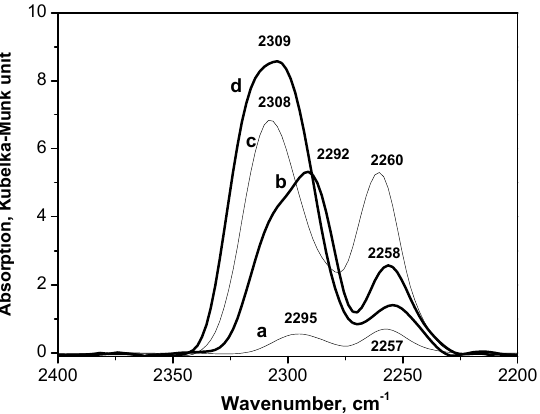
Figure 4. Diffuse reflectance infrared spectroscopy (DRIFT) spectra upon adsorption of CD 3 CN on ZrO 2 (a), TiO 2 (b), 18%WO 3 -ZrO 2 (c), 20%WO 3 -TiO 2 (d). Conditions: 96 Torr, 20 °C.